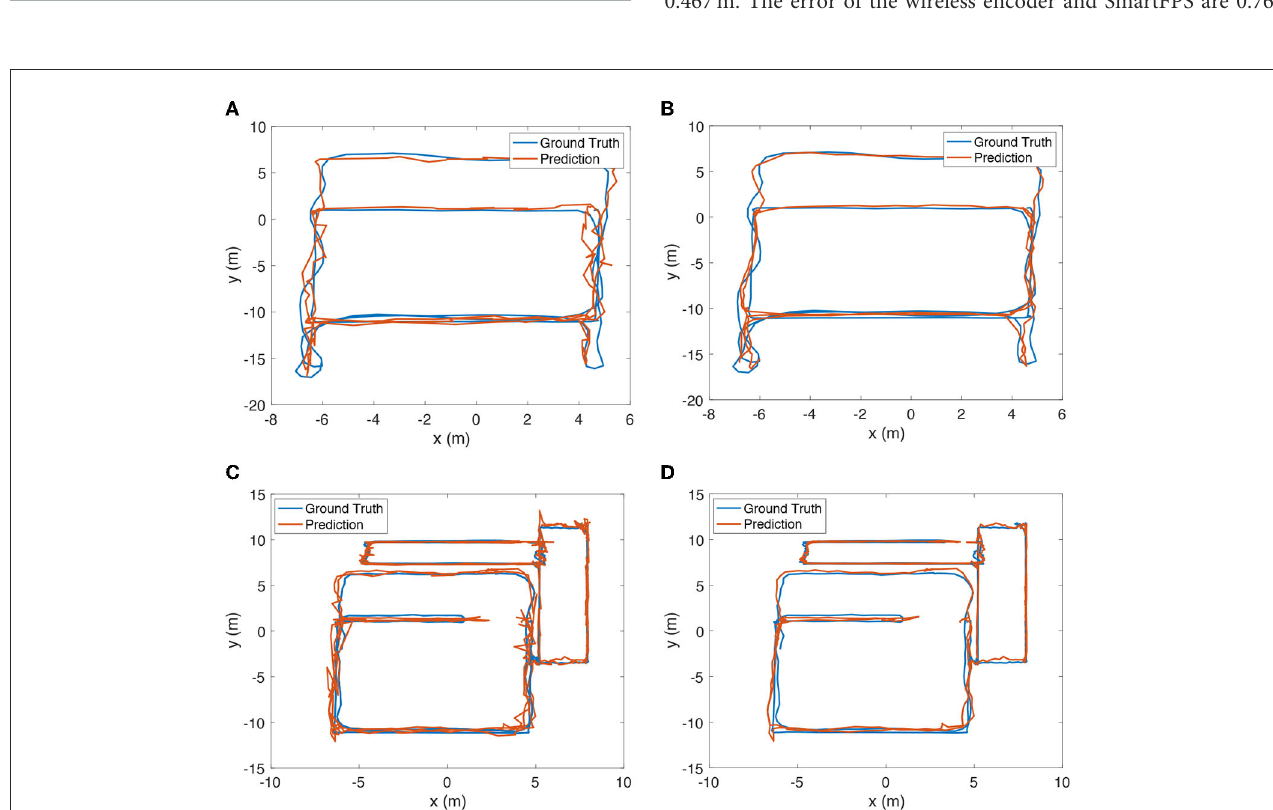
FIGURE7 (A) Estimated trajectory of test set 1 by wireless positioning encoder of SmartFPS. (B) Estimated trajectory of test set 1 by SmartFPS. (C) Estimated trajectory of test set 2 by wireless positioning encoder of SmartFPS. (D) Estimated trajectory of test set 2 by